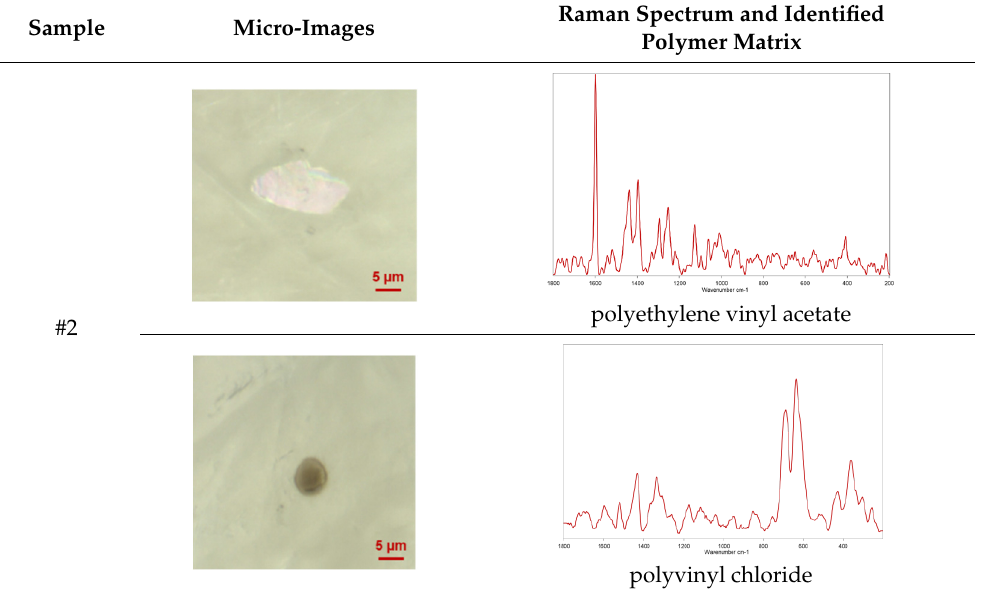
Table 2. Micro-images of the identified MPs and corresponding Raman spectra.